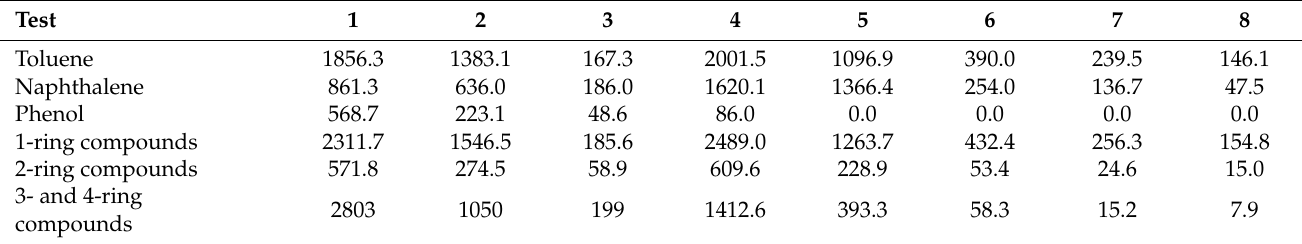
Table 5. Tar content in the product gas (mg/Nm 3 -N 2